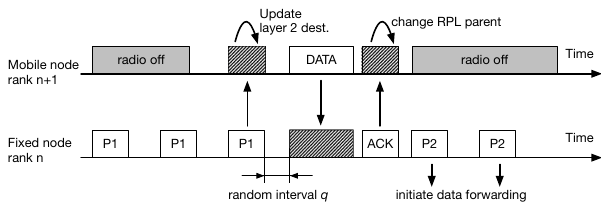
Figure 2. Preamble is overhead - Channel